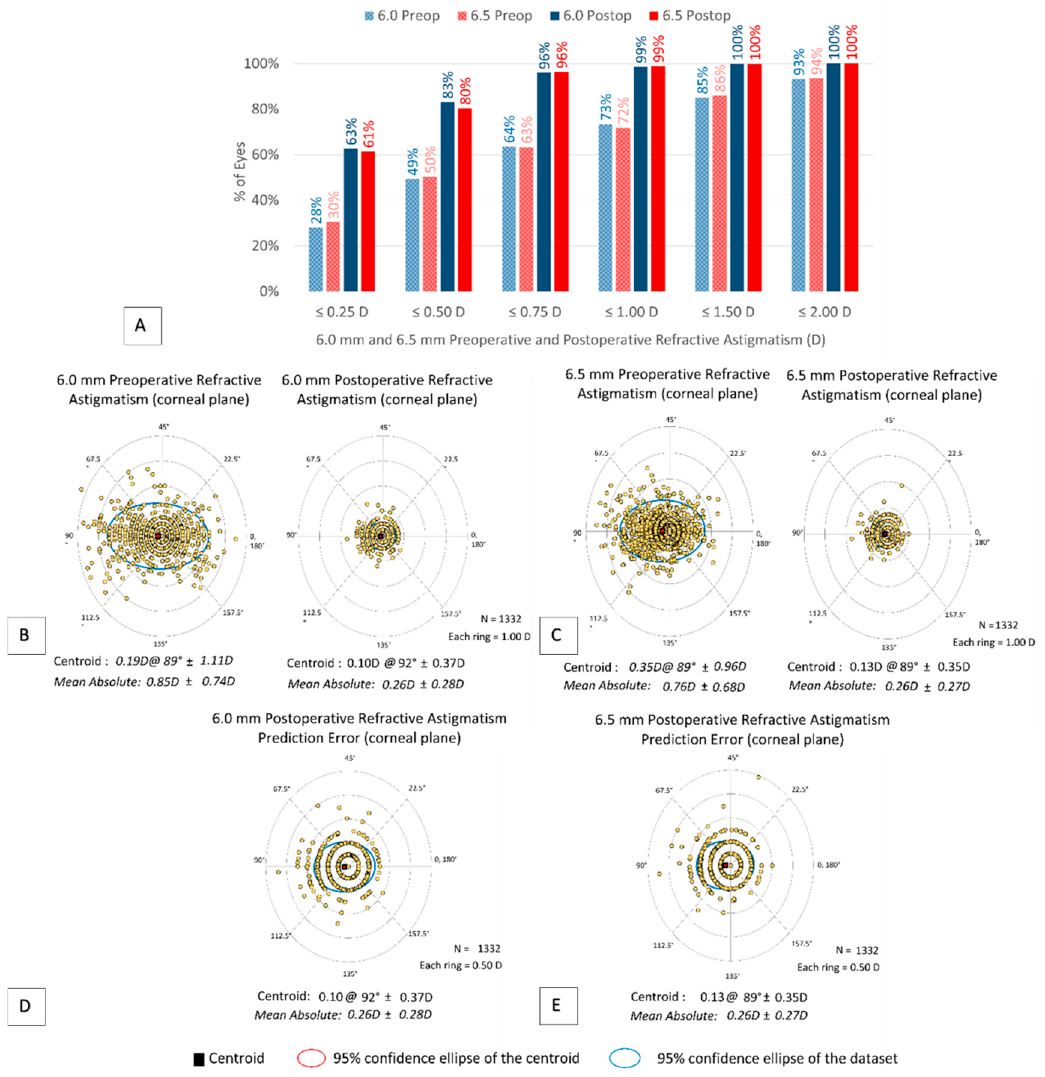
Figure 2. Vector analysis of 6.0 and 6.5 mm groups at 12 months. ( A ) Comparison of preoperative and postoperative manifest cylinder in diopters for 6.0 and 6.5 mm groups; ( B ) comparison of preoperative and postoperative refractive astigmatism for 6.0 mm group; ( C ) comparison of preoperative and postoperative refractive astigmatism for 6.5 mm group; ( D ) postoperative refractive astigmatism prediction error for 6.0 mm group; ( E ) postoperative refractive astigmatism prediction error for 6.5 mm group.